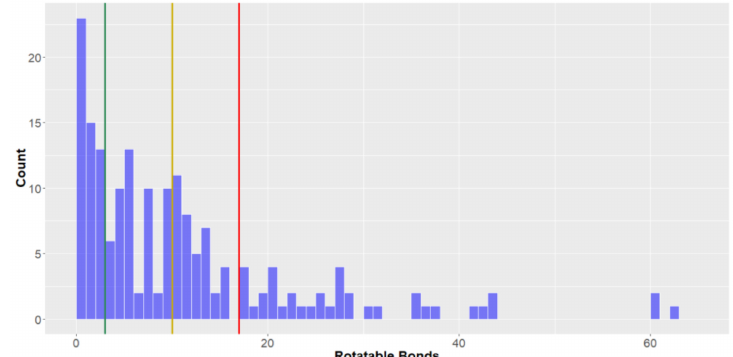
Figure 11. The statistical distribution of the rotatable bonds of all analysed compounds (green = 3, compounds < 3 are in the lead-like space; yellow = 10, compounds < 10 are in the drug-like space; red = 17, compounds < 17 are in the known drug space. Total number of compounds = 179.